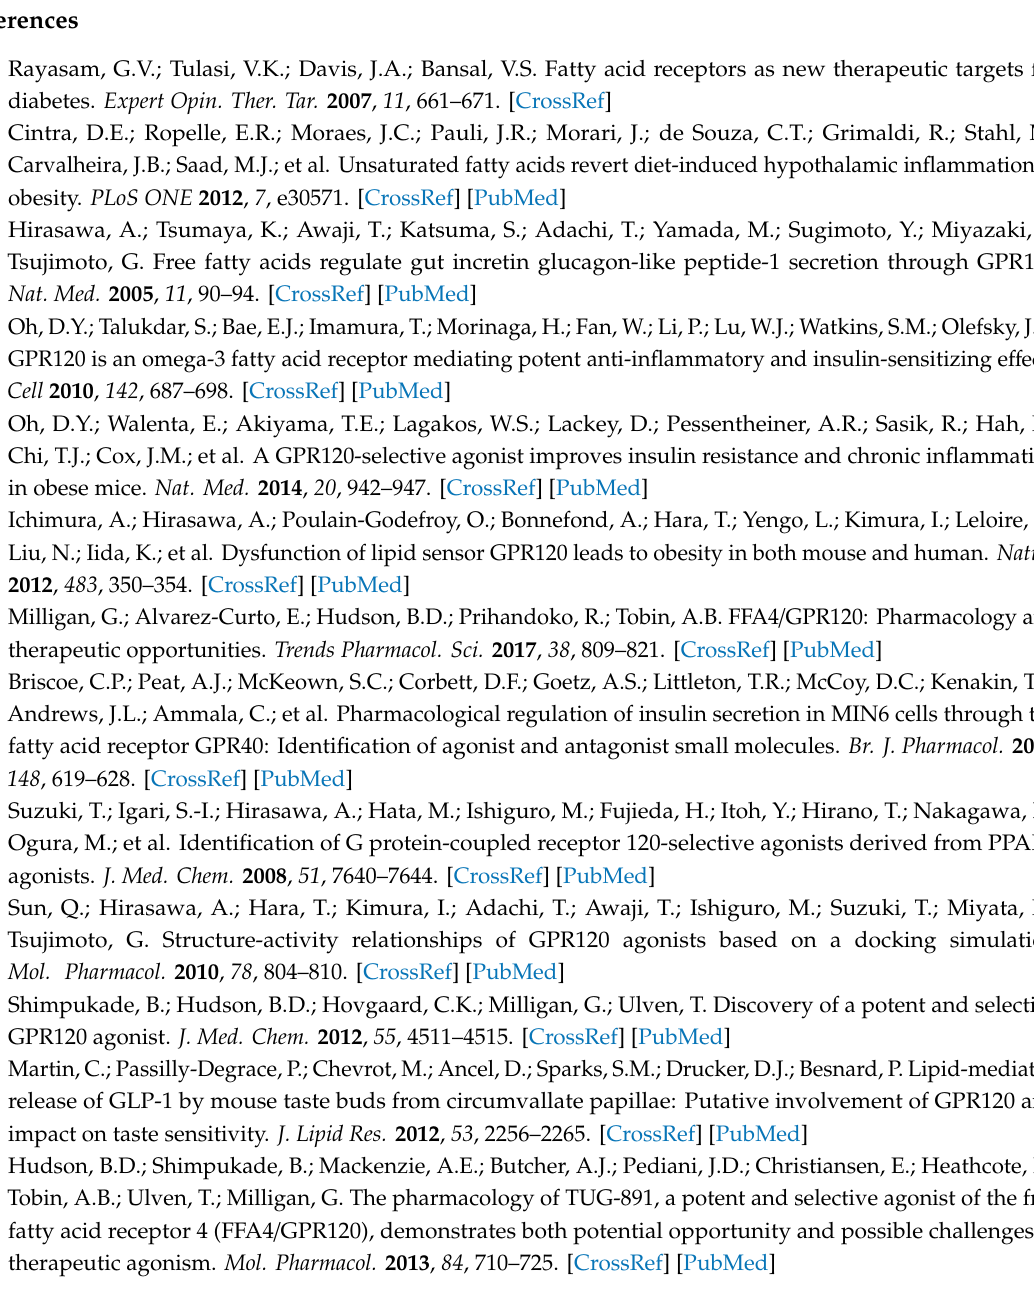
Supplementary Materials: The following are available online. Figure S1. Structures of the triterpenoids; Table S1. Corrected NMR chemical shifts of 3- O -protocatechuoylceanothic acid (1); Table S2. [Ca 2 + ]i in hGPR120-CHO cells; Table S3. Comparison of [Ca 2 + ]i between hGPR120-CHO cells and G α 16-CHO cells; The 1 H and 13 C NMR spectra of 4 , 6 and 1 and HPLC analysis of synthetic and natural 1